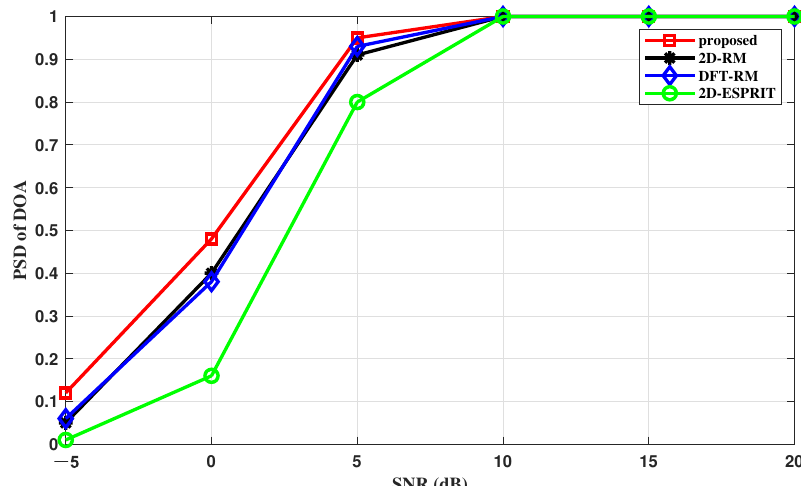
Figure 10. PSD of the DOA estimation versus SNR.